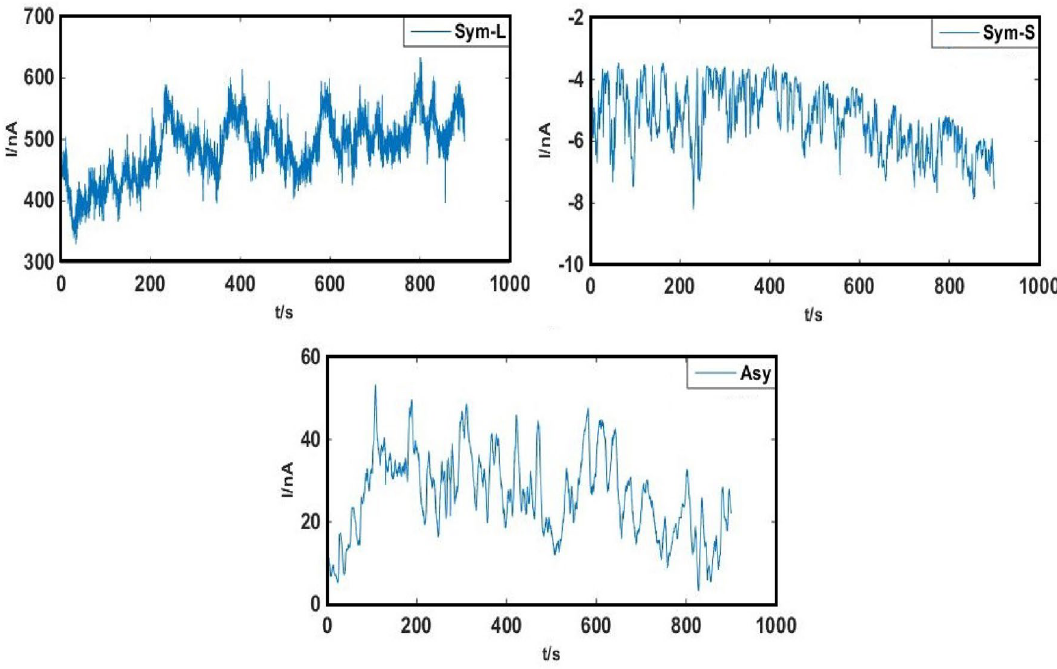
Figure 4. The original ECN signals of Sym and Asy electrodes in 0.3 M NaCl + 0.3 M Na 2 SO 4 solution at 60 °C.